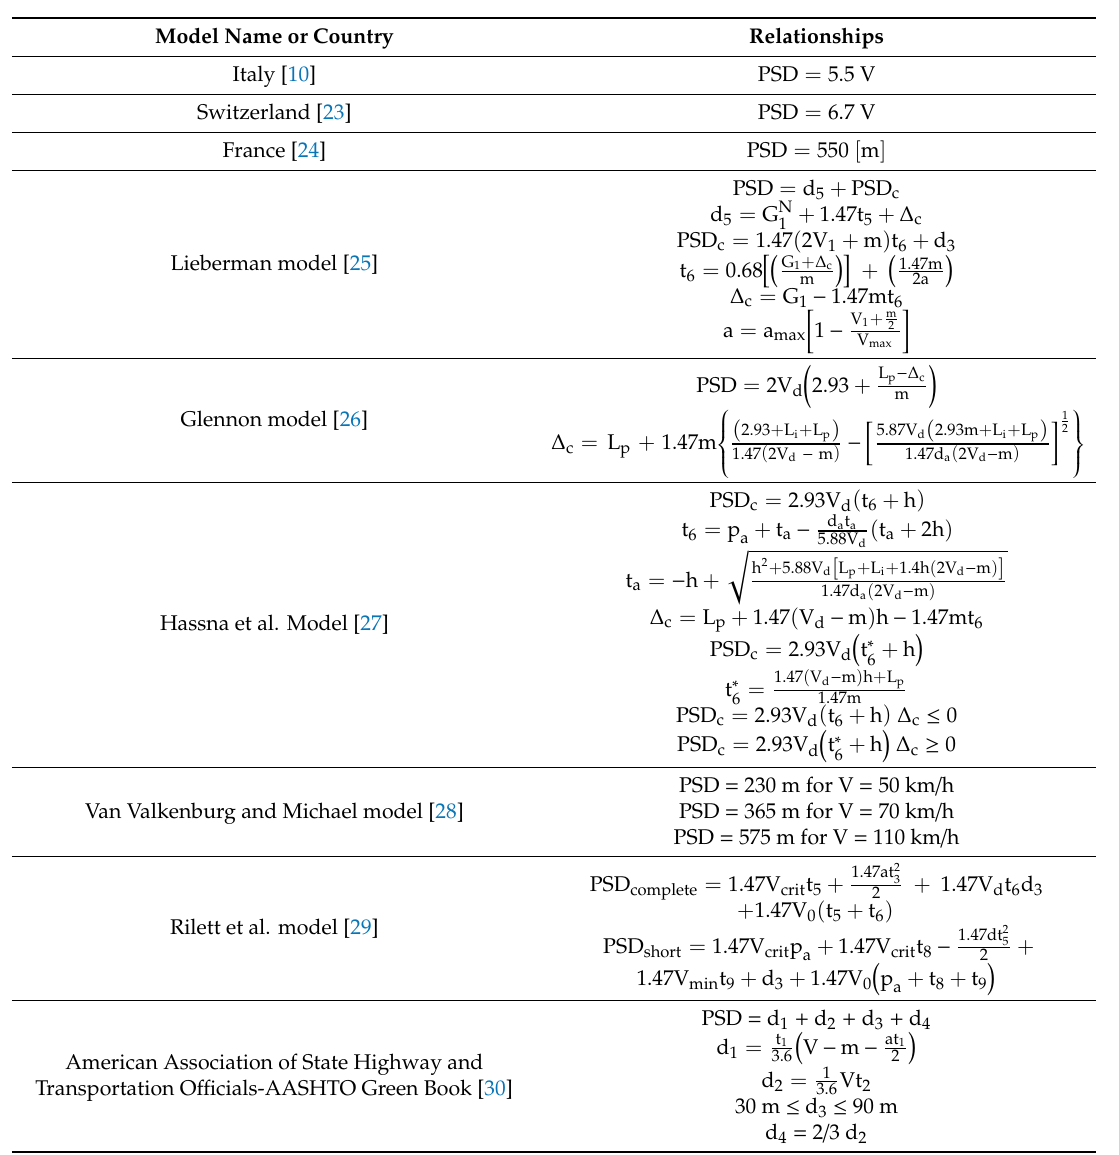
Table 2. Passing sight distance (PSD)